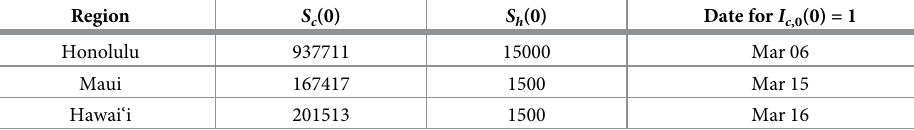
Table 3. Susceptible population for each region and first detected symptomatic individual. All other variables have an initial value of 0. Kaua‘i is not represented in this table since the model cannot be implemented for this county due to the very low count of daily cases.